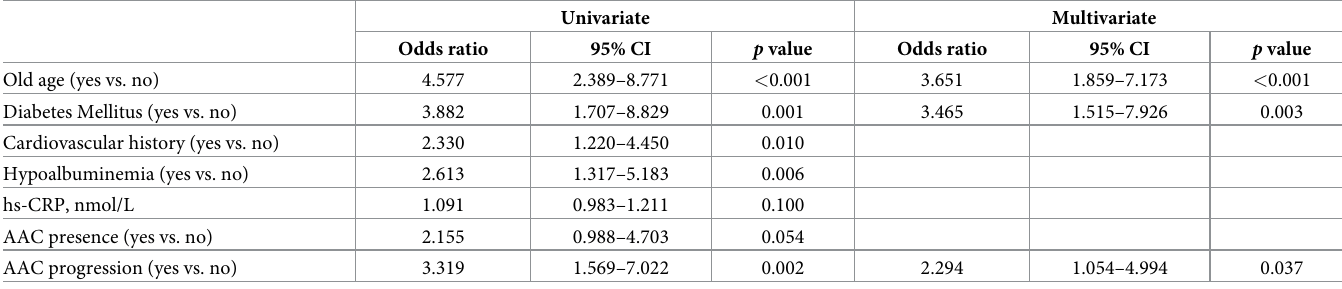
Table 5. Predictors of all-cause